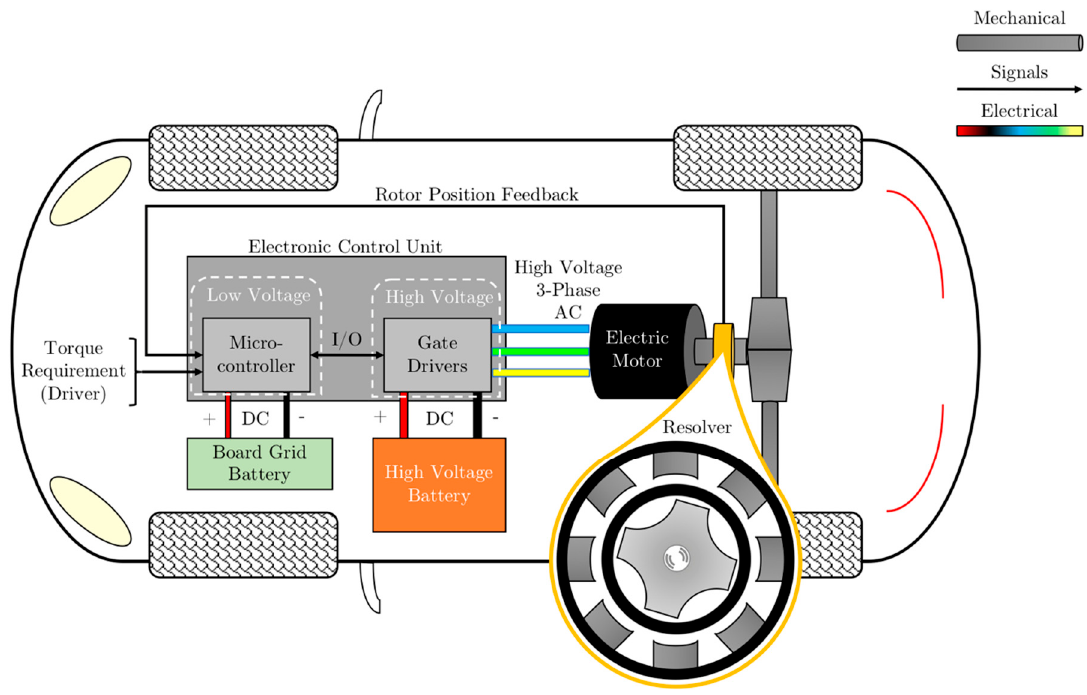
Figure 1. State-of-the-art electric drive train system containing four main components: the powertrain battery (high voltage), an electronic control unit, the three-phase electric motor and the rotor position sensor (e.g., resolver) [2–7].